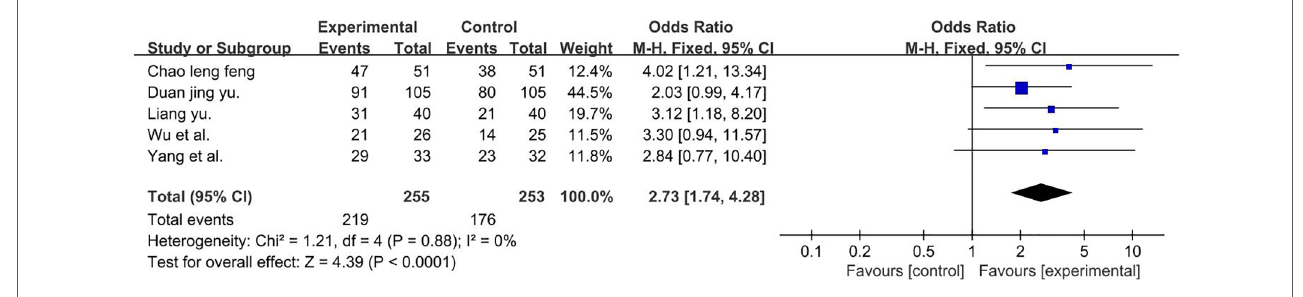
FIGURE 14 Forest plot showing MD (with 95% CI) for language improvement rate of the included studies comparing the experimental and control groups. Note: fi xed- effect model [MD=2.73; 95% CI (1.74, 4.28); P <0.01]. The analysis results were statistically signi fi cant.